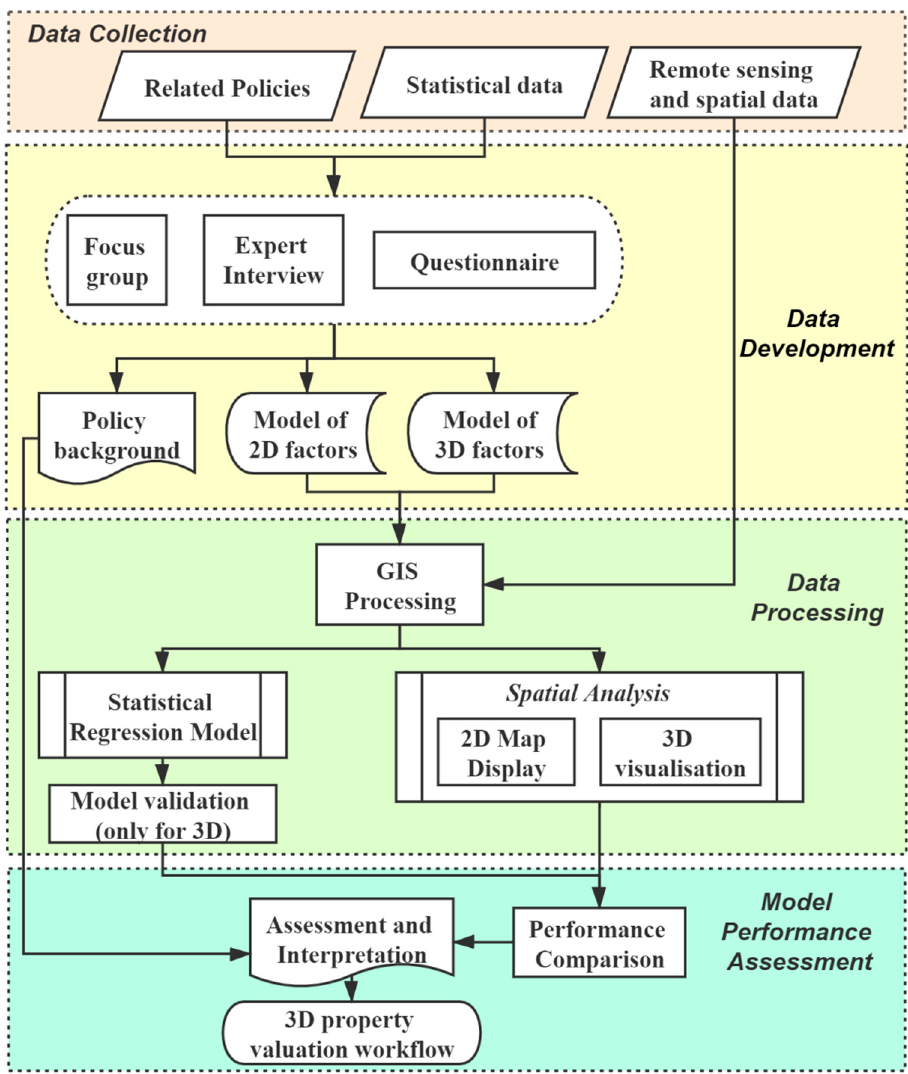
Figure 1. Methodology